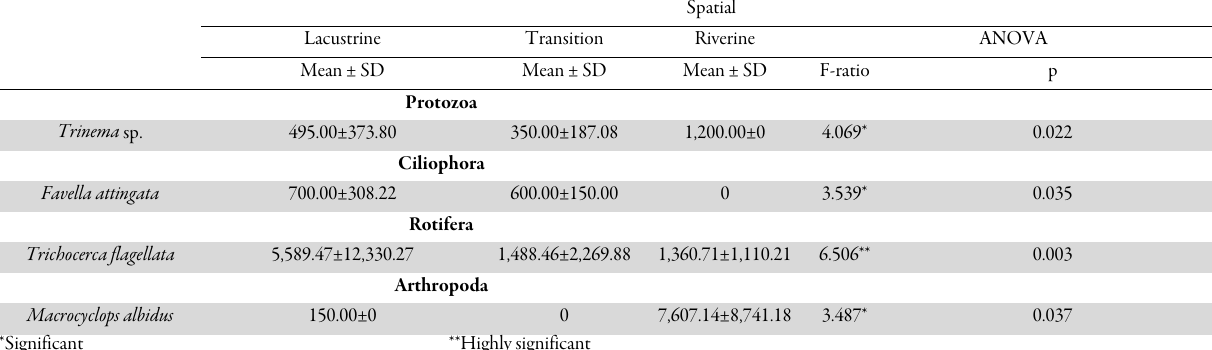
Table 5. Spatial variation of aquatic microfauna between the three sampling stations